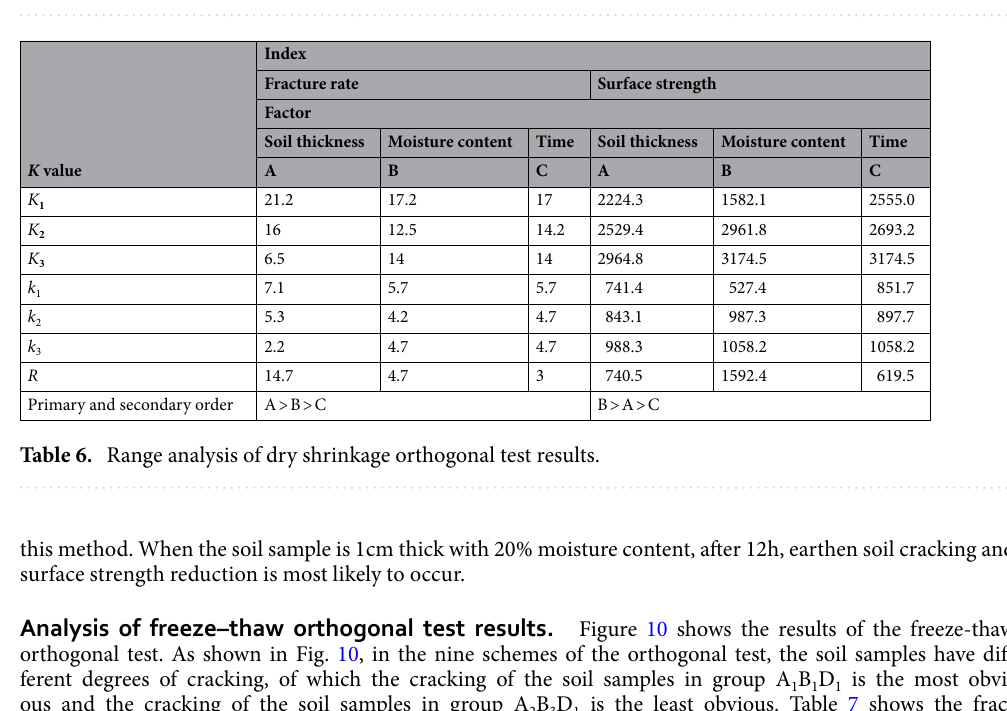
Figure 9. Nominal surface strength results of dry shrinkage orthogonal test. ( a ) A 1 B 1 C 1 , ( b ) A 1 B 2 C 2 , ( c ) A 1 B 3 C 3 , ( d ) A